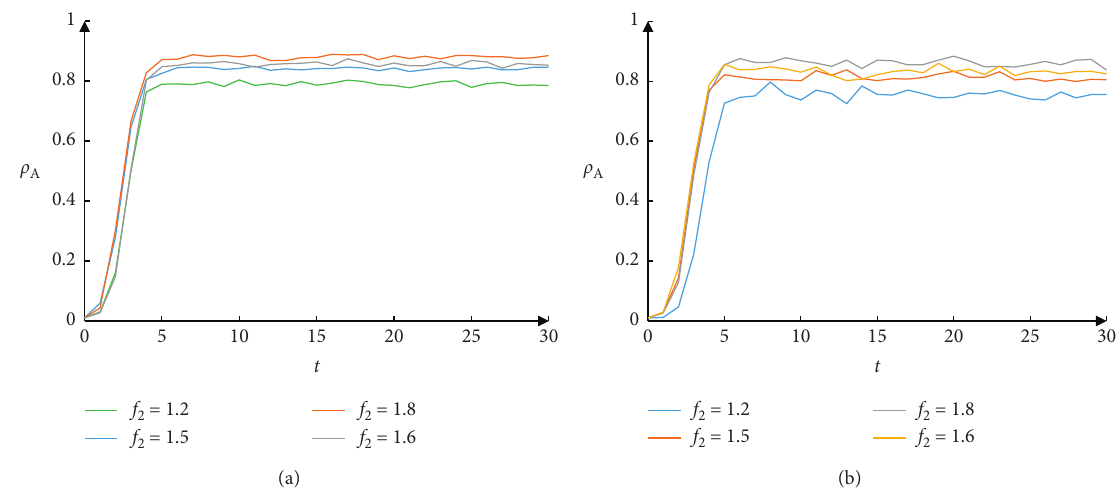
Figure 18: Changes in ρ A under different epidemic stages: (a) Model I; (b) Model